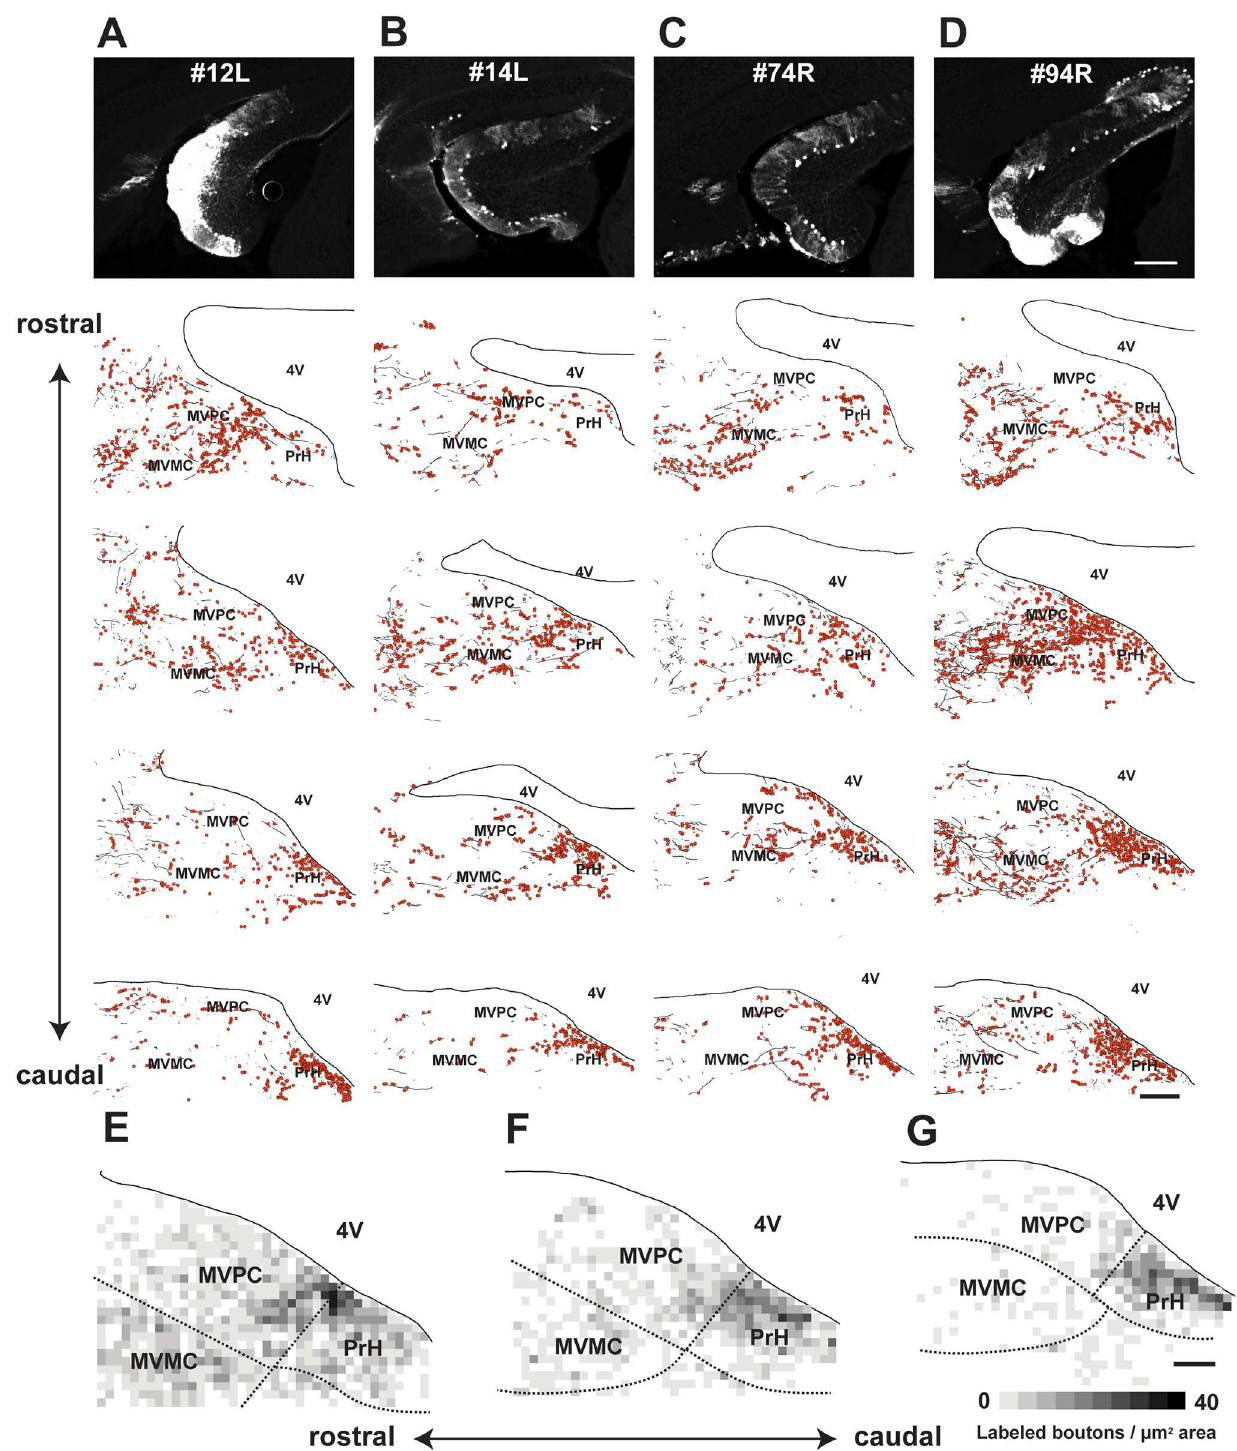
Fig 2. Distribution of FL P-cell axons and their boutons in MVN/PrH after FL lentivirus injections. A – D , Tracing of anterogradely- labeledFL axons in four mice. Despite the difference of density of GFP expressionamong four cases shown in the photographs in the top row, labeledFL P-cell axons were distributed throughout MVN and PrH in all of the four cases. Distributions of the labeledaxons in MVN and PrH for each injectionare summarized in 4 images that are shown from the rostral to caudal MVN/PrH. A , case (#) 12L; B , #14L; C , #74R; D , #94R. LabeledFL P-cell axons and their boutons are respectively shown by black lines and red circles. E – G , Summary of distribution of FL P-